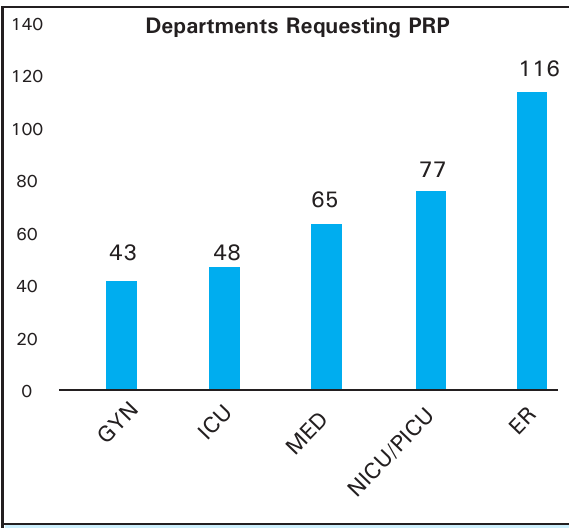
Figure 4. Showing the different clinical departments requesting